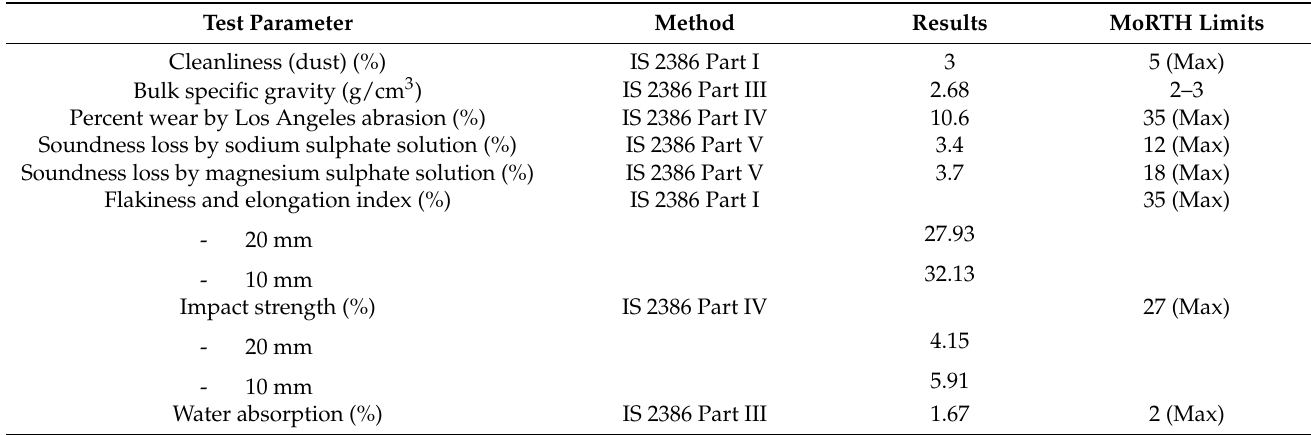
Table 1. Aggregate properties.